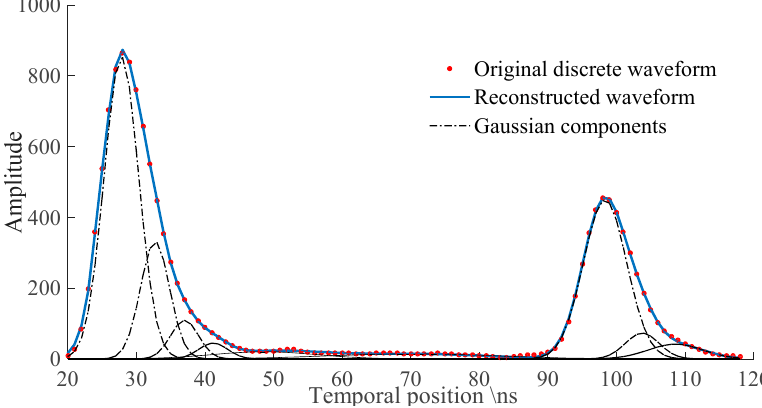
Figure 6. Reconstructed continuous waveform and original discrete waveform.